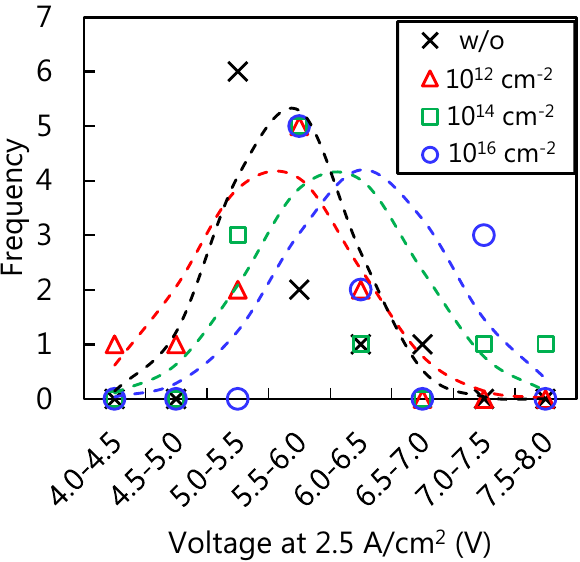
Figure 2. Frequency of the voltages at a forward current of 2.5 A/cm 2 for the PiN diodes with and without proton implantation. The dotted lines are fitting with the normal